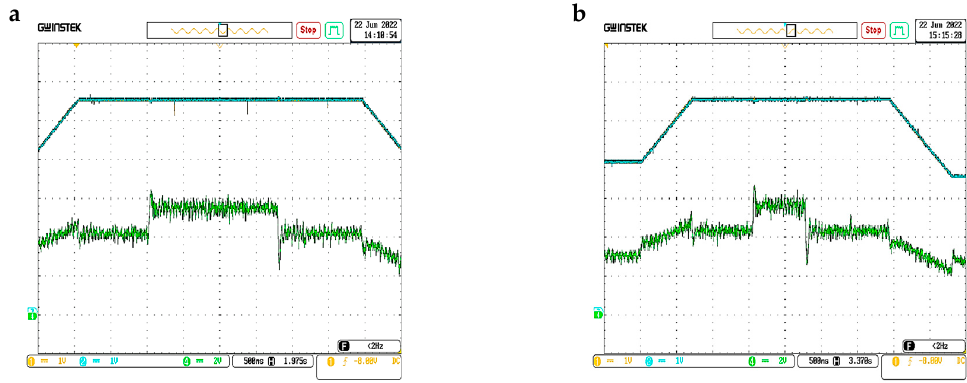
Figure 19. Zoom 1 of electromagnetic torque and speed response for speed profile 1 and